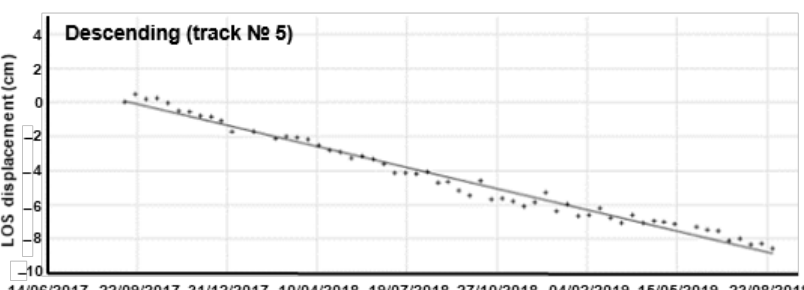
Figure 8. Time-series of ISBAS-derived cumulative LOS ground displacement for point A (indicated in Figure 6), the Right Bank landslide (also known as the Pravoberezhniy landslide).